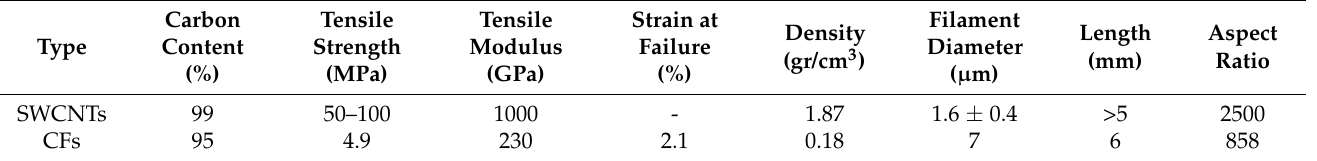
Table 1. Properties of single-walled carbon nanotubes (SWCNTs) and microfibers (CFs).